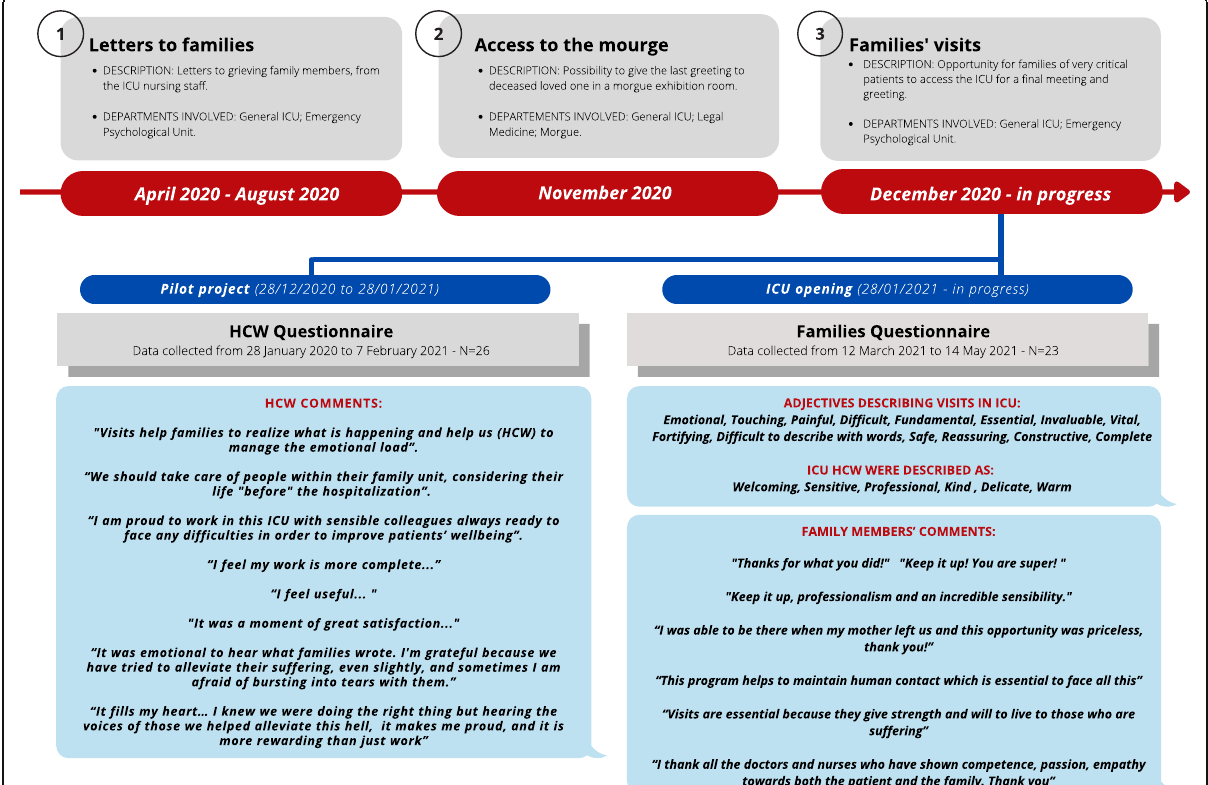
Fig. 2 Project timeline and surveys. Project timeline; the different departments involved; some of HCW and family members ’ comments, collected through the questionnaires. Abbreviations: ICU , intensive care unit; HCW , healthcare